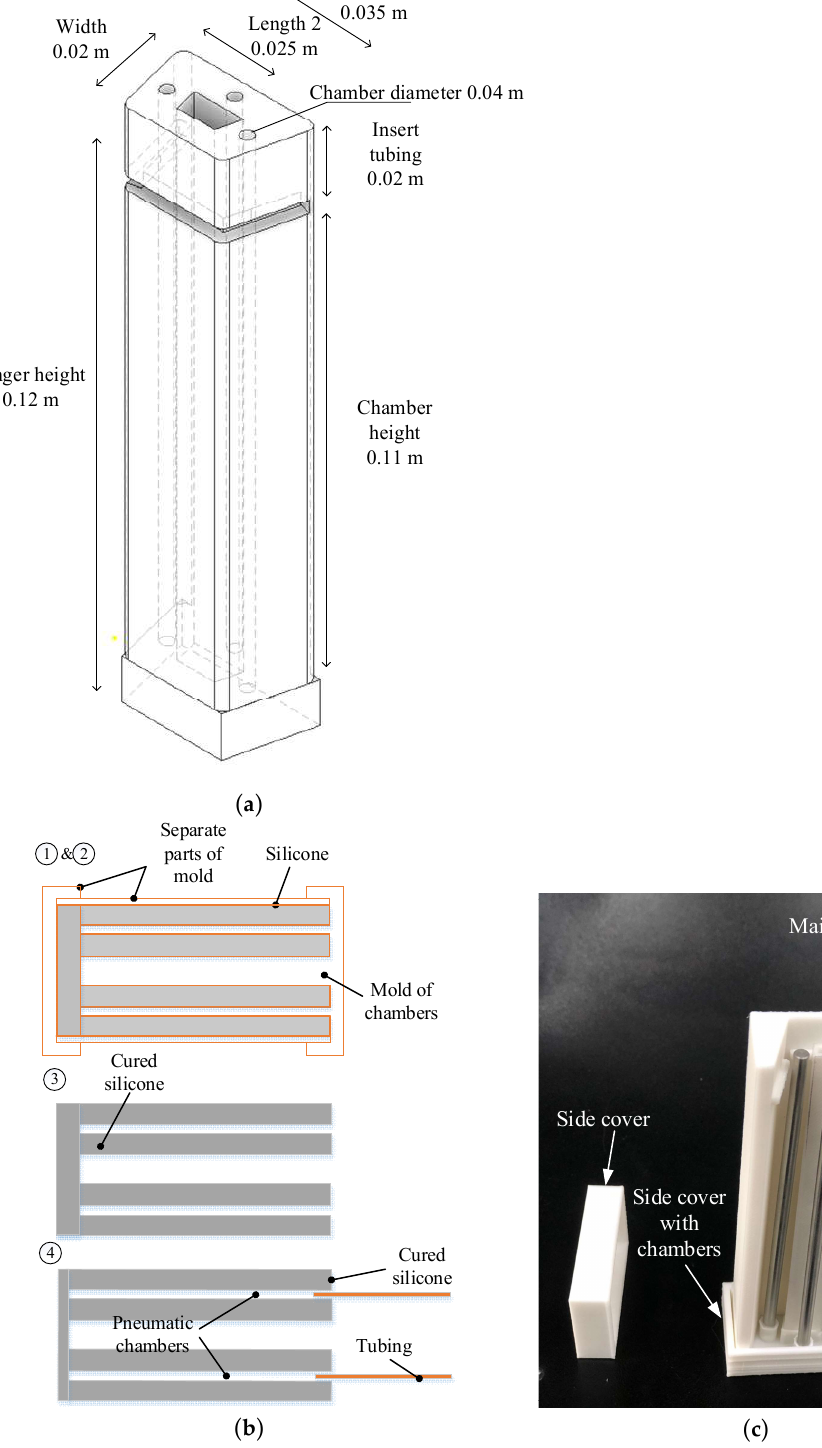
Figure 5. Soft finger design ( a ) Computer aided design (CAD) drawing of a proposed finger. ( b ) Fabrication process for making soft actuator; ( 1 , 2 ): Assemble the mold and fill it with liquid silicone; ( 3 ): After 5 h curing, remove actuator from mold; ( 4 ): Connect tubing with silicone epoxy. ( c ) Assembled mold for